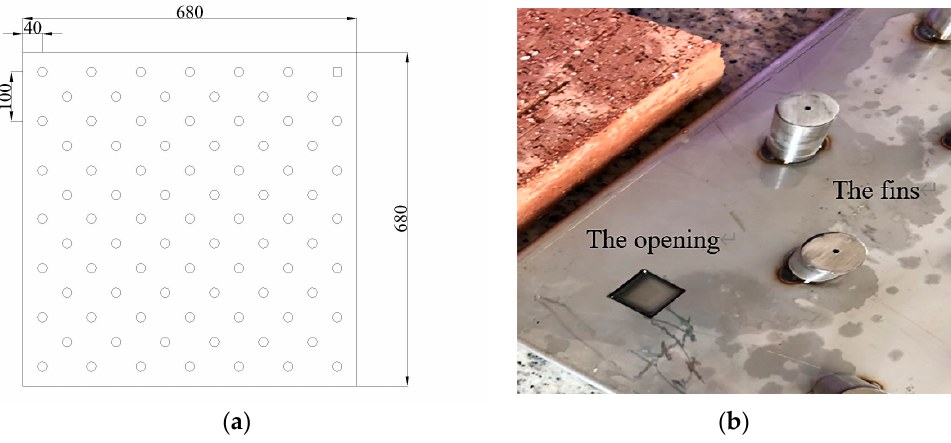
Figure 2. Geometry structure of the PCM plate: ( a ) Structure diagram; ( b ) Real object.